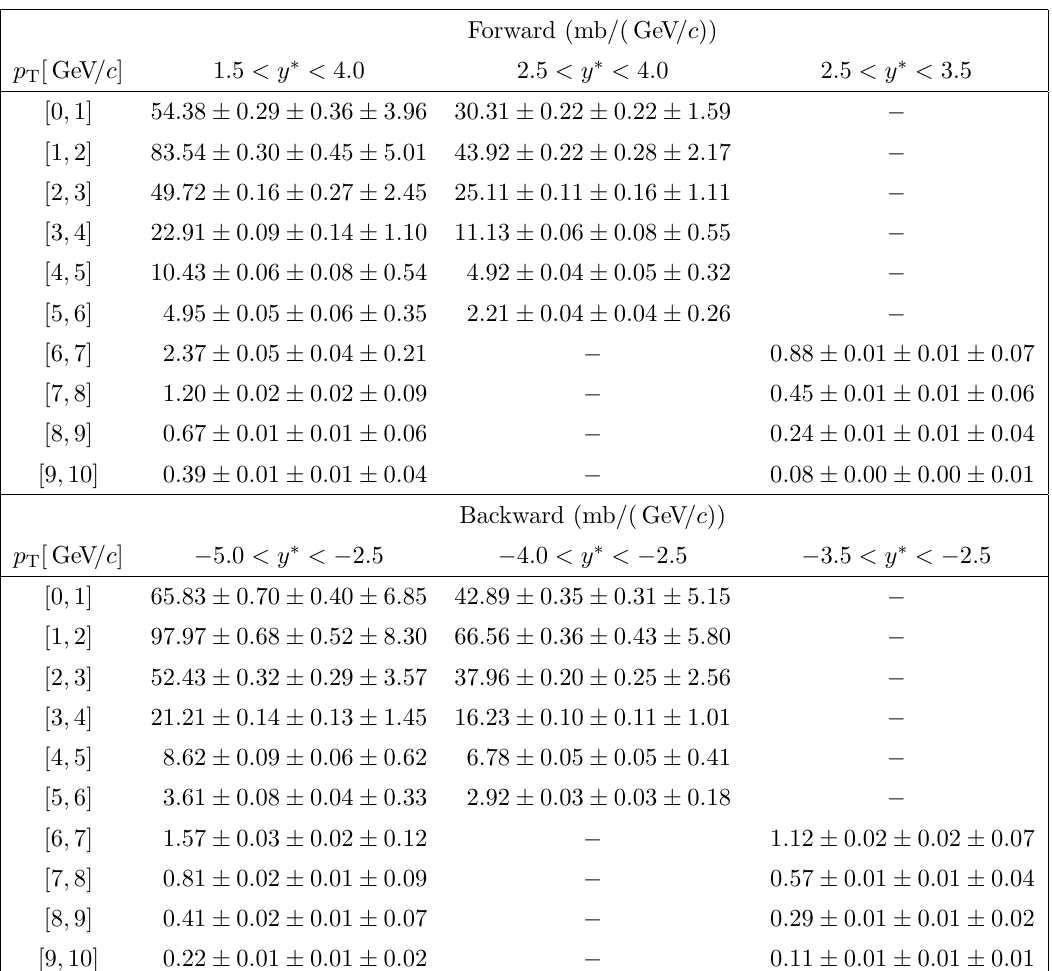
Table 3 . Measured di(cid:11)erential cross-section d (cid:27) (mb/( GeV =c )) for prompt D 0 meson production d p T as a function of p T in p Pb forward and backward data, respectively. The (cid:12)rst uncertainty is statistical, the second is the component of the systematic uncertainty that is uncorrelated between bins and the third is the correlated component. The results in the last two columns are integrated over the common rapidity range 2 : 5 < j y (cid:3) j < 4 : 0 for p T < 6 GeV =c and over 2 : 5 < j y (cid:3) j < 3 : 5 for 6 < p T < 10 GeV =c